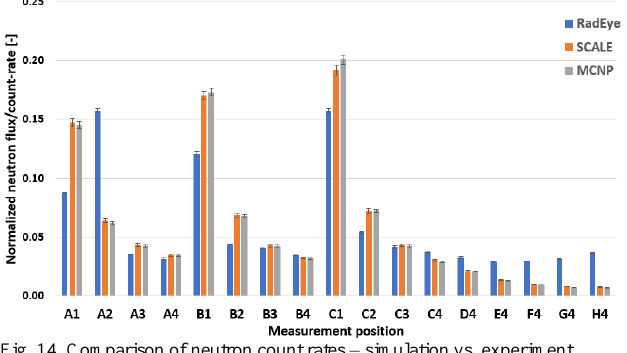
Fig. 14. Comparison of neutron count rates – simulation vs. experiment